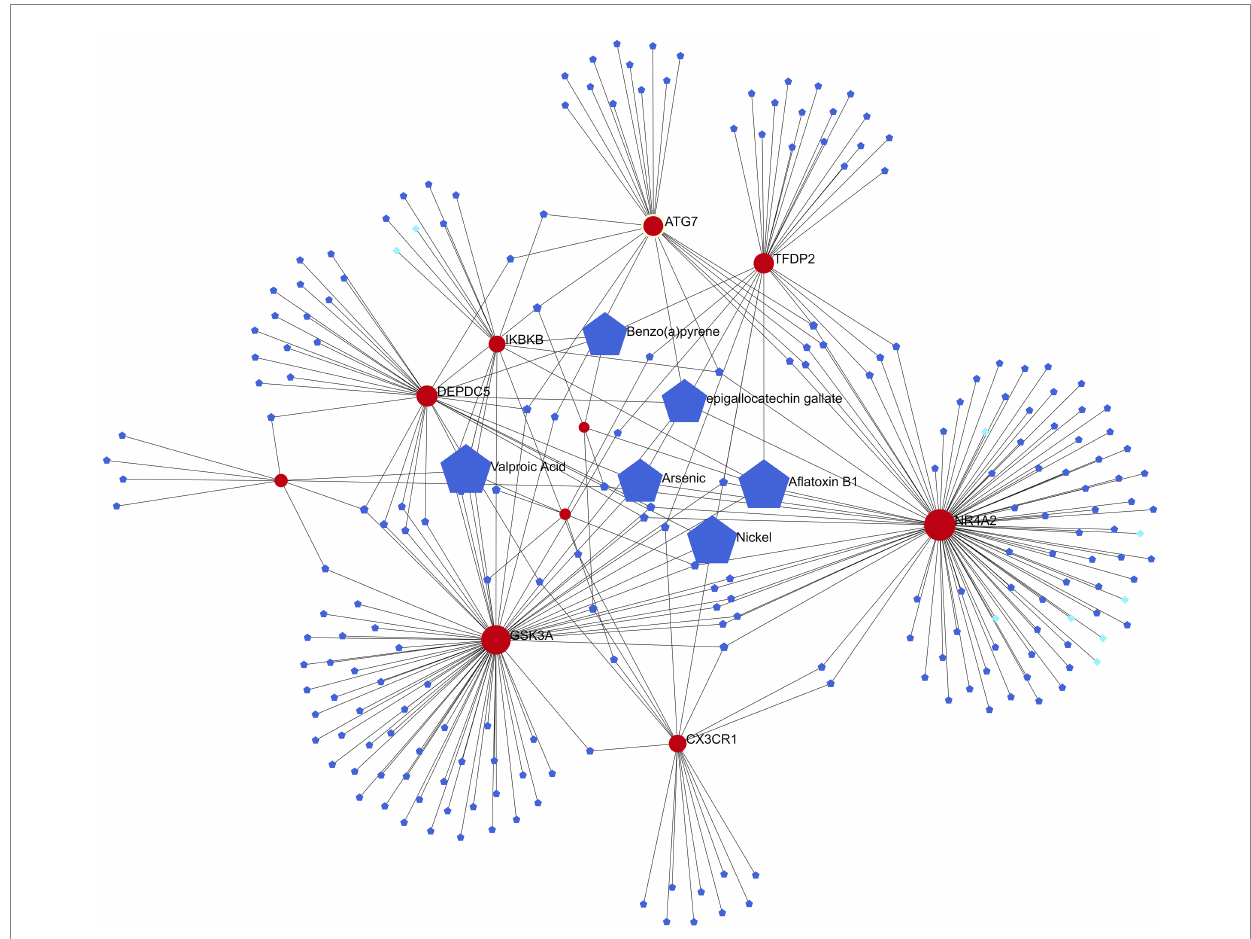
FIGURE 7 Gene-drug interaction network (red represents candidate genes, light blue data from DrugBank, and dark blue data from Comparative Toxicogenomics